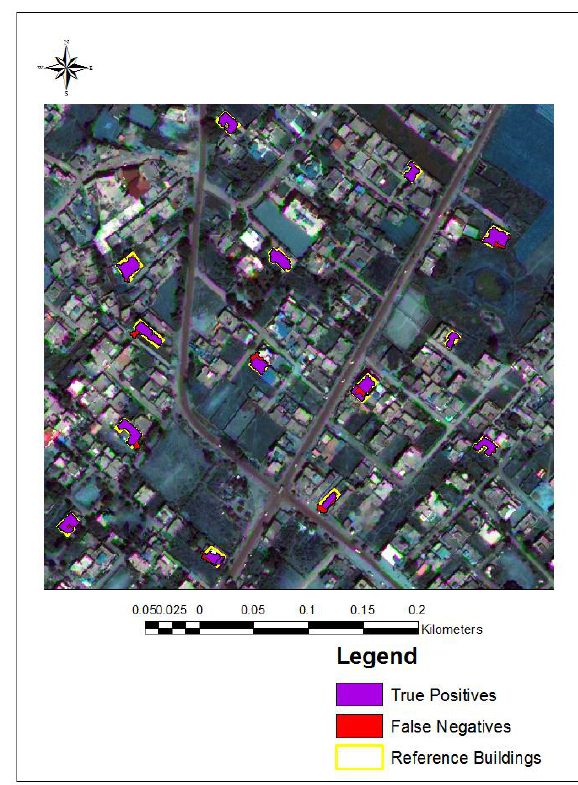
Figure 13 Accuracy assessment for Multi-Resolution algorithm